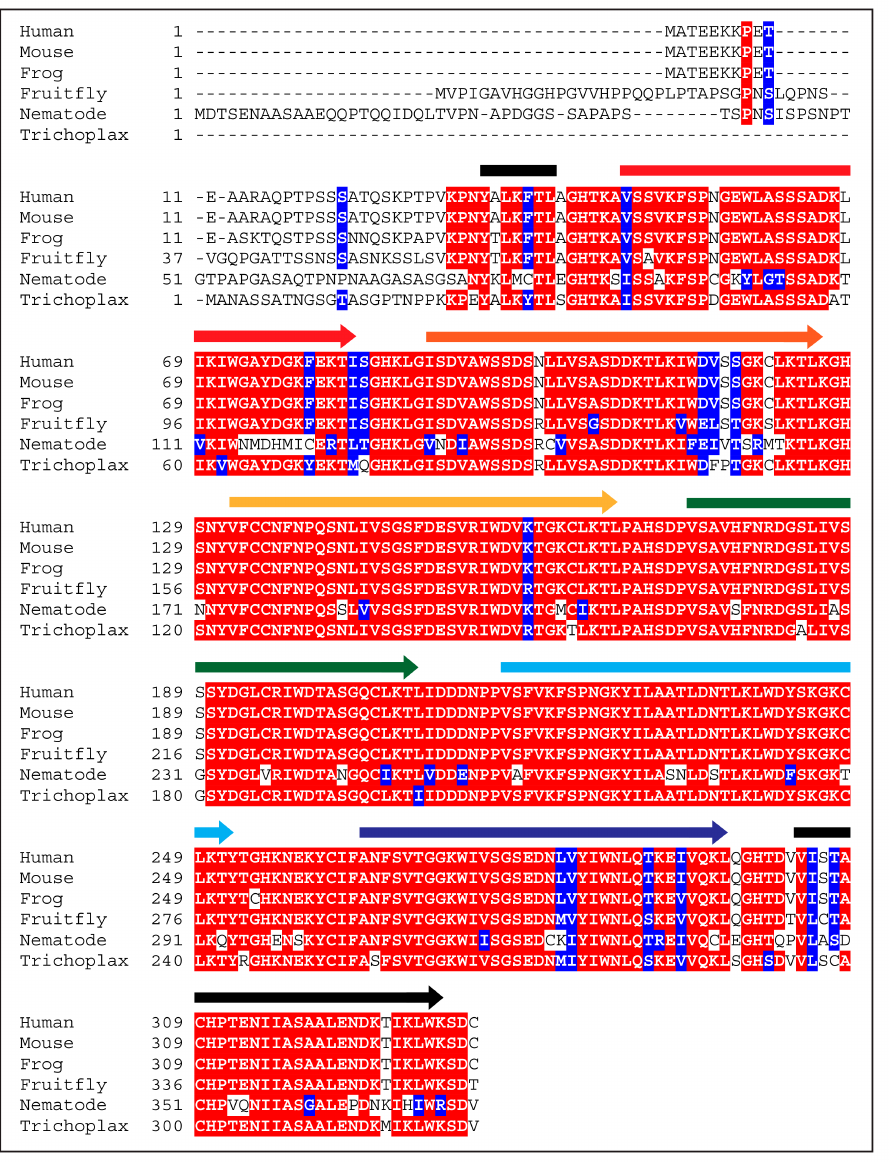
Figure 2. WDR5 is highly conserved in multicellular organisms. Alignment of WDR5 amino acid sequences from indicated species demonstrates high conservation of WDR5 proteins. Colored arrows above sequences indicate the residues involved in each of the seven β -propellers and match the colors in Figure 1. Residues highlighted in red are identical. Residues highlighted in blue are homologous. Homo sapiens (NP_438172.1), Mus musculus (NP_543124.1), Xenopus tropicalis (NP_001011411.1), Drosophila melanogaster (NP_524984.1), Caenorhabditis elegans (Q17963.1), Trichoplax adhaerens